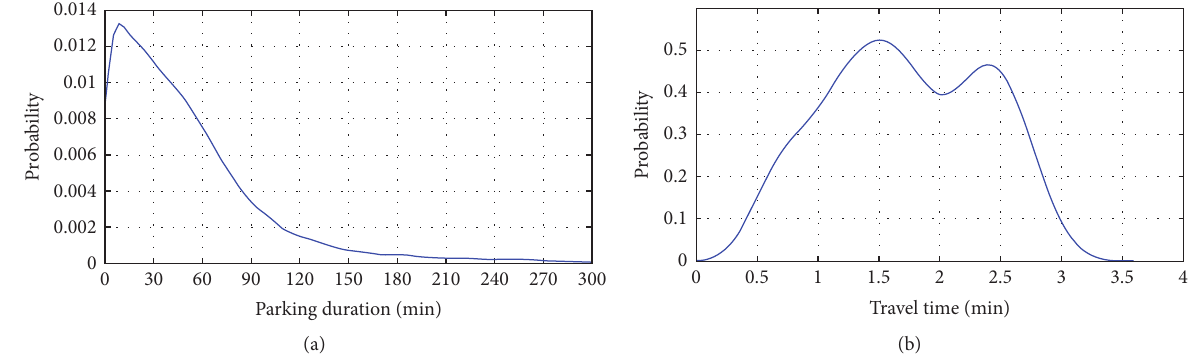
Figure 4: Probability densities of (a) parking durations and (b) travel times from car park to CS